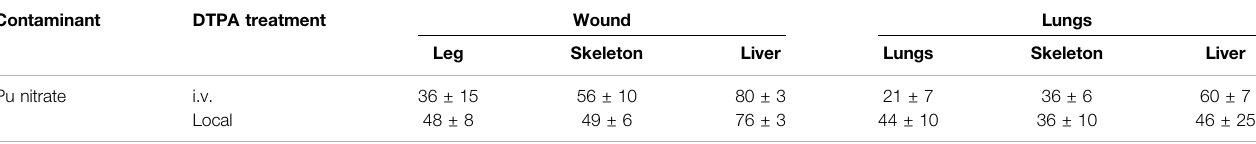
TABLE 1 | Reduction of Pu tissue activity levels following single local or systemic DTPA treatment. Contaminant